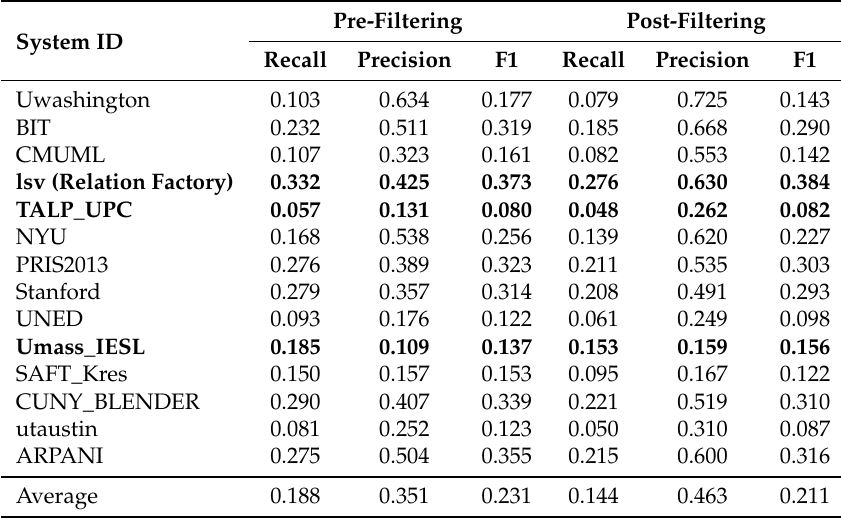
Table 3. Global Evaluation using the TAC KBP 2013 Slot Filling scorer on the test dataset for all systems before and after